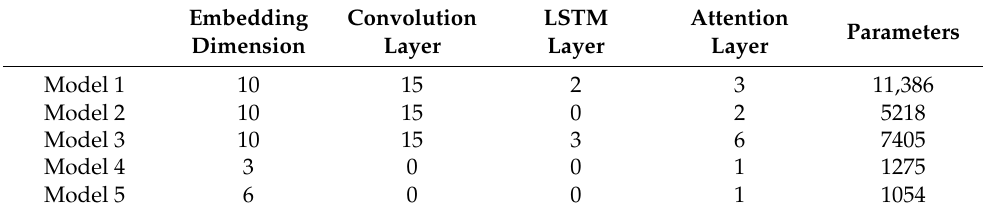
Table 1. Five different model architectures used in AiCPP.